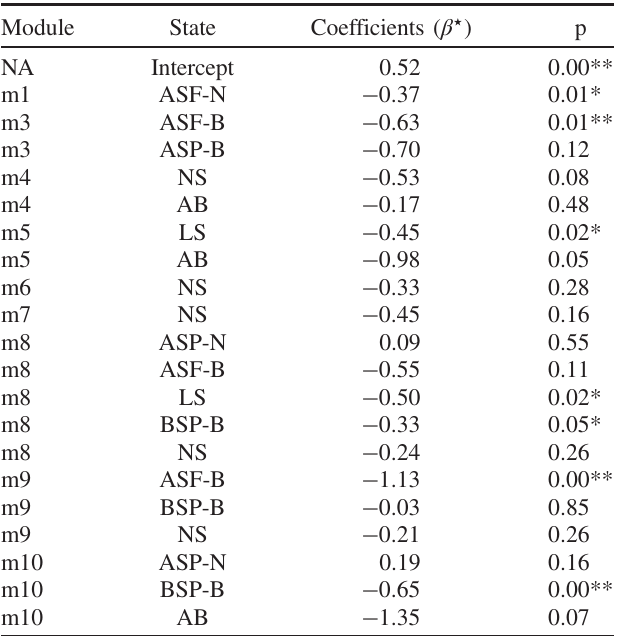
TABLE VI. Estimated coefficients and p values of regression (4) for the nine-state model (level III). Module